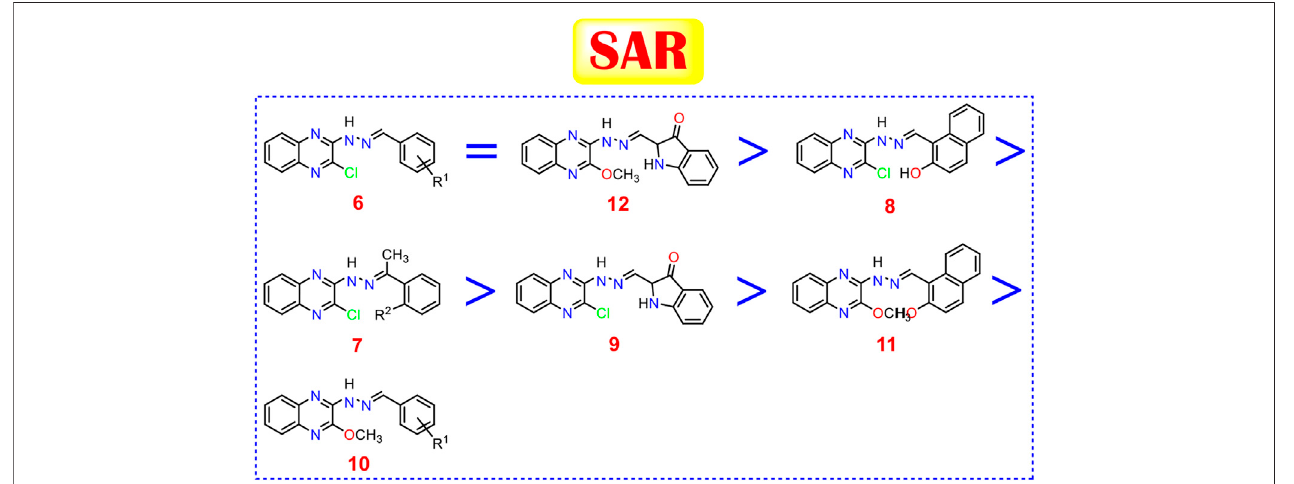
FIGURE 11 | Structure-activity relationships of the newly synthesized quinoxaline candidates as